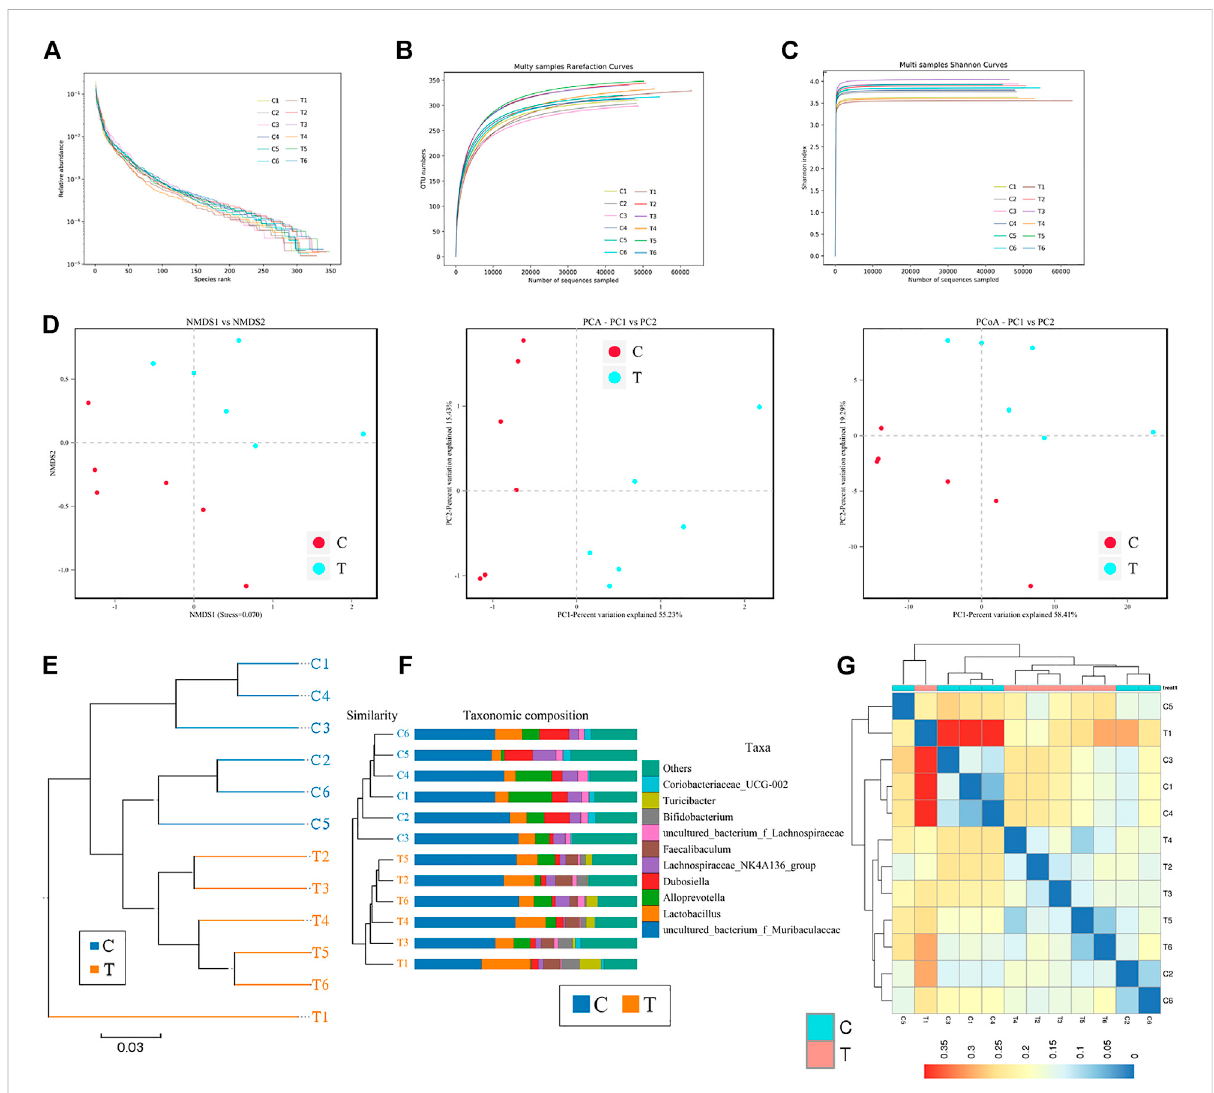
FIGURE 7 α - and β -diversity analysis (A) As evident, α -diversity analysis showed that the rank abundance curve was fl at, indicative of a high degree of uniformity in species composition. (B) The rarefaction curve appeared smooth. (C) Shannon index curve. (D) Principal component analysis, principal co-ordinate analysis, and non-metric multidimensional scaling analysis. Microbial communities between the CHMACS-treated and control groups showedobviousdifferences. (E) Unweightedpairgroupmethodwitharithmeticmeanclustering. (F) Clusteringandhistogramcombination. (G) Heatmap of sample